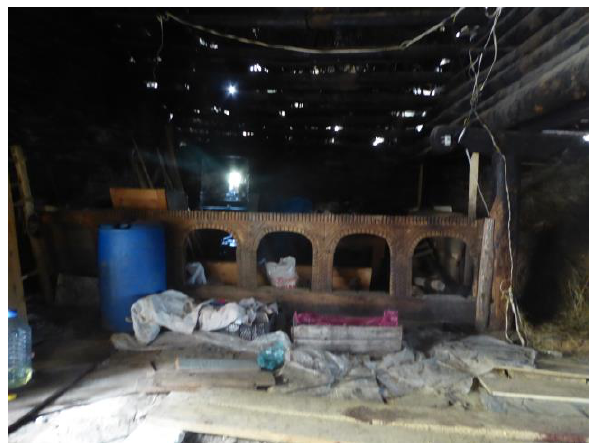
Figure 3. Wooden partition inside a machub in Zhibiani, Upper Svaneti, CI-ESG, 2018.